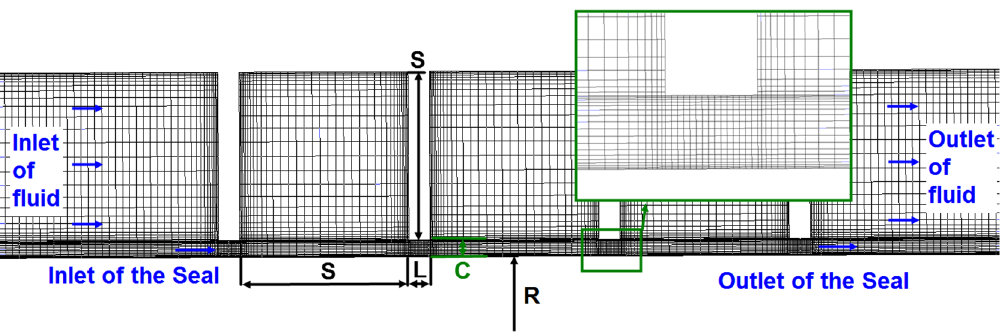
Figure 2. The mesh of fluid and the size of the seal.